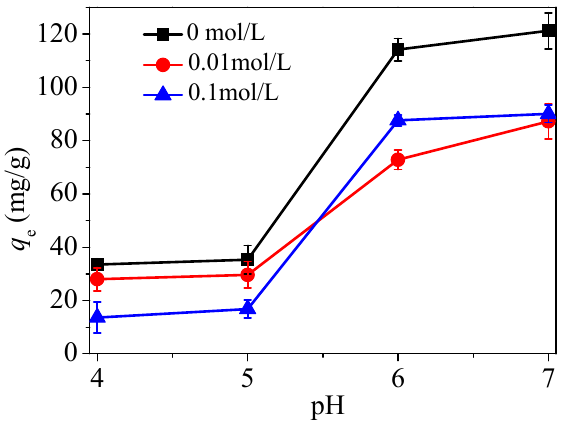
Figure 11. Effect of electrolyte concentration on adsorption of Hg(II) by CoFe 2 O 4 @SiO 2 –NH 2 .